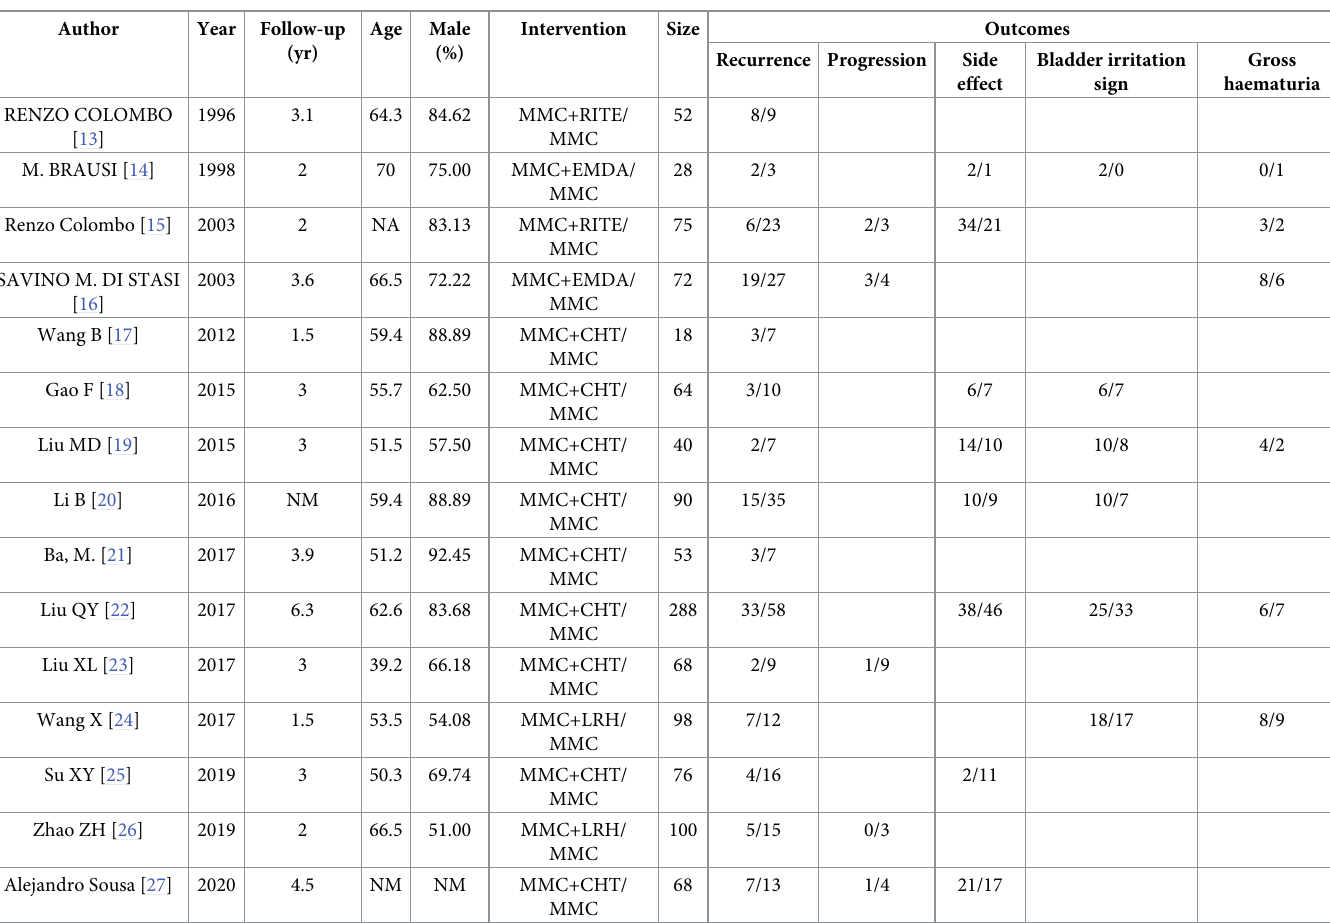
Table 1. The main characteristics of included